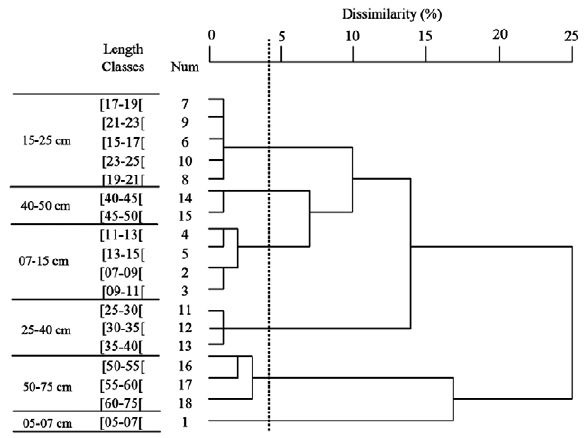
Fig. 3. – Dendrogram representing hake dietary similarity according to size classes, on the basis of mean percentage contribution (Cp: W%) of each